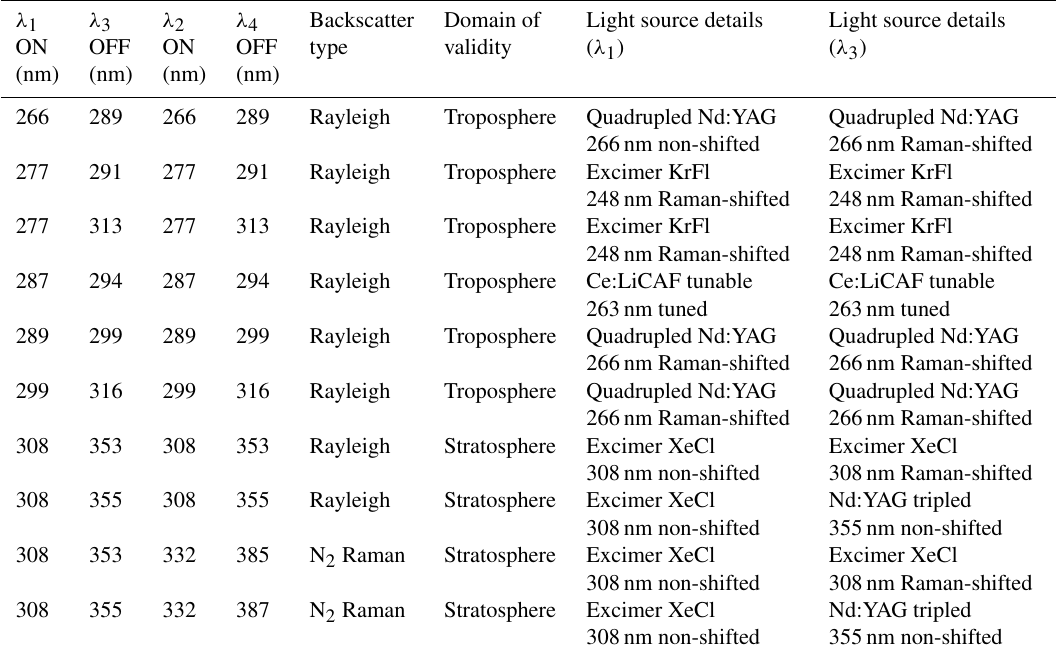
Table 2. List of most commonly used ozone DIAL wavelength pairs. λ 1 λ 3 λ 2 λ 4 Backscatter Domain of Light source details Light source details ON ON OFF type